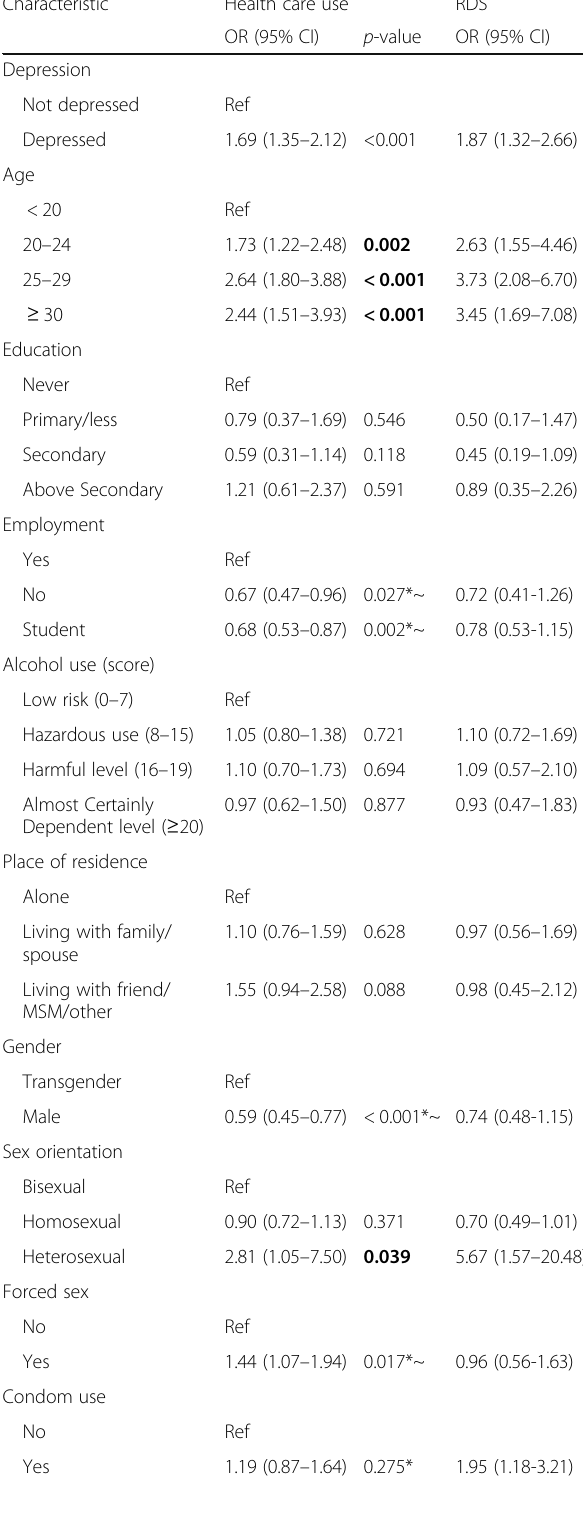
Table 2 Bivariate Associations with Health Care Utilization